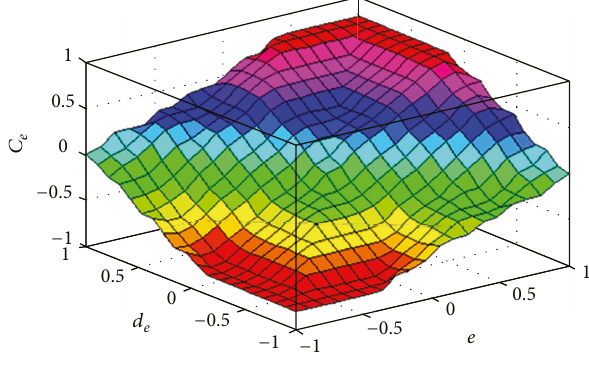
Figure 6: Surface for the torque 𝐶 𝑒 .